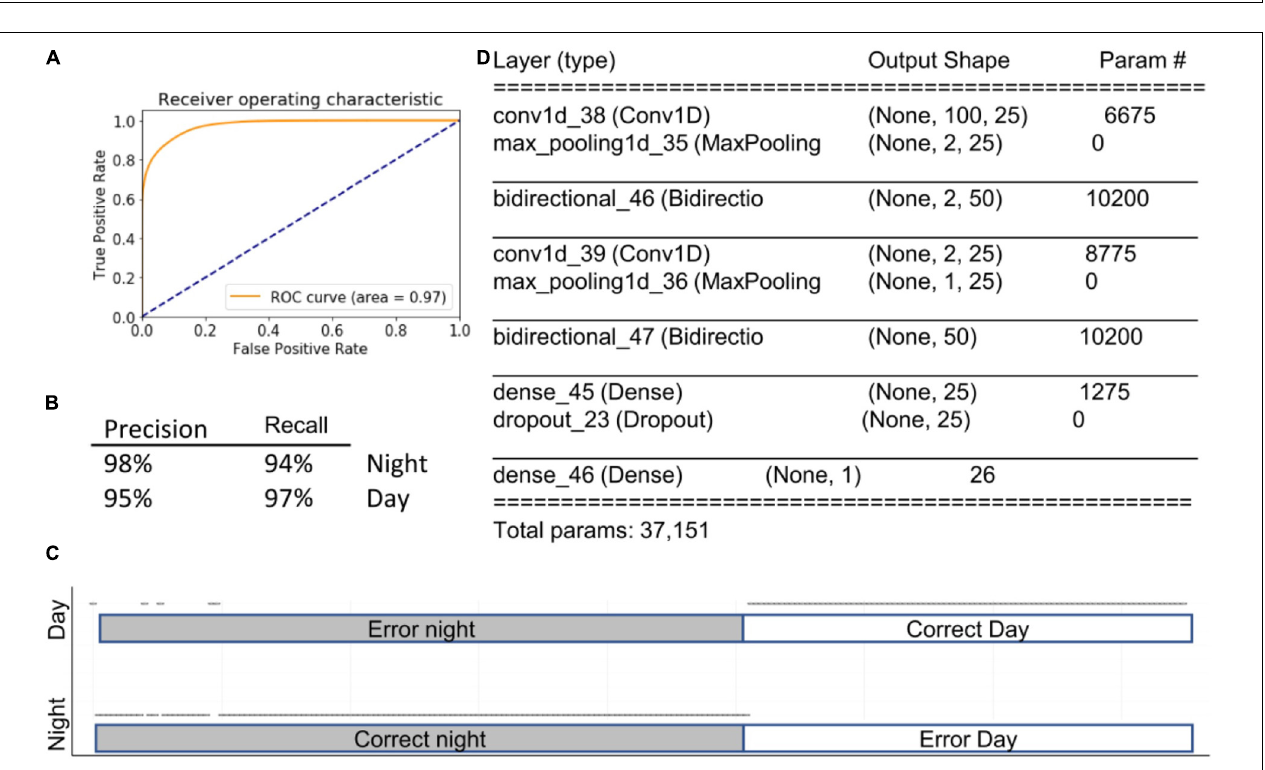
FIGURE 6 | Ensemble. Inserts show ROC (A) curve, precision summary (B) , and graphical representation of the ratio of true positives to false positives (C) . Open circles represent predictions. The majority of predictions are correct, and therefore circles overlap into apparent lines. Dots above marked bars represent incorrect predictions.